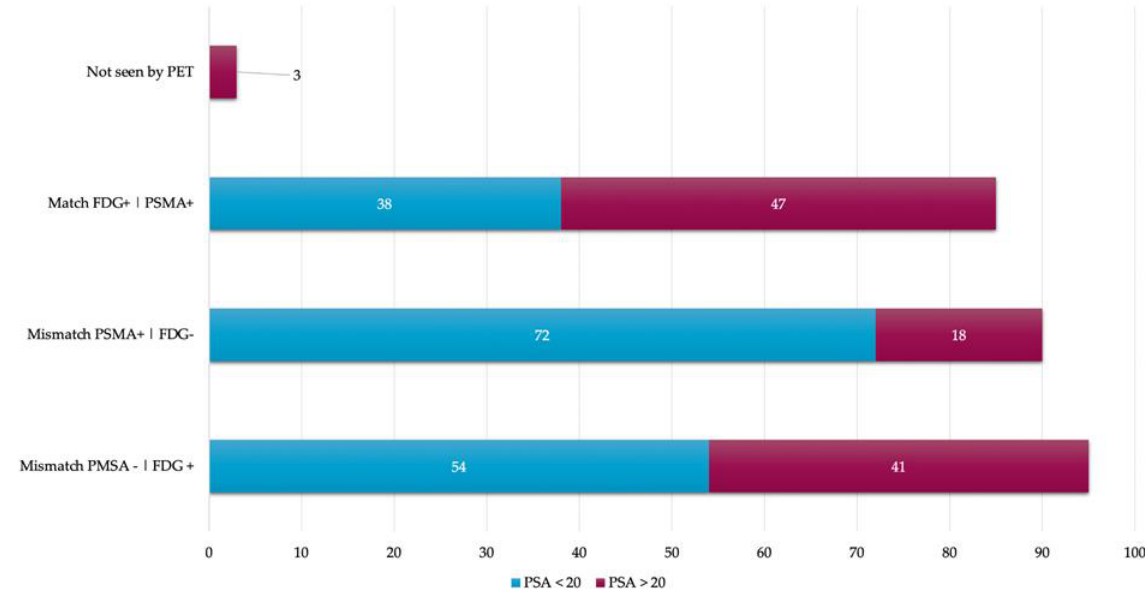
Figure 7. Lesions detection rate according to PSA levels.